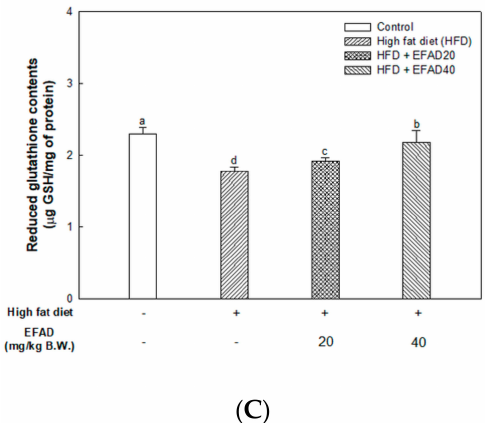
Figure 5. E ff ect of ethyl acetate fraction from Aruncus dioicus var. kamtschaticus (EFAD) on oxidative stress and impaired antioxidative system induced by HFD in brain tissue of mice. ( A ) Malonaldehyde (MDA) contents. ( B ) Superoxide dismutase (SOD) contents. ( C ) Reduced glutathione (GSH)